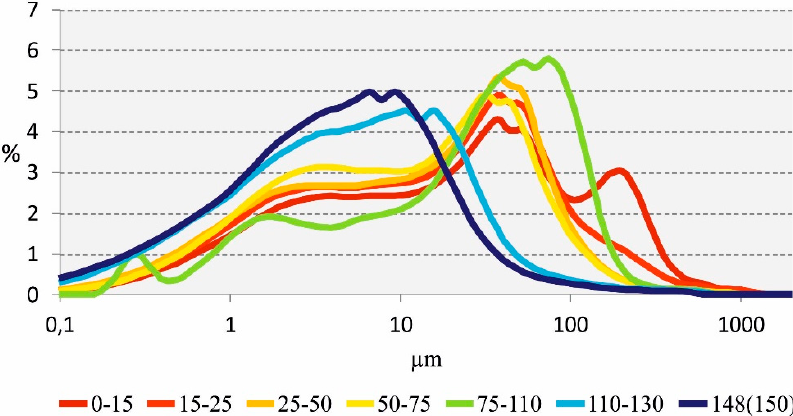
Figure 13. Grain size differential curves for various parts of the pedocomplex with Calcic Kastanozem.